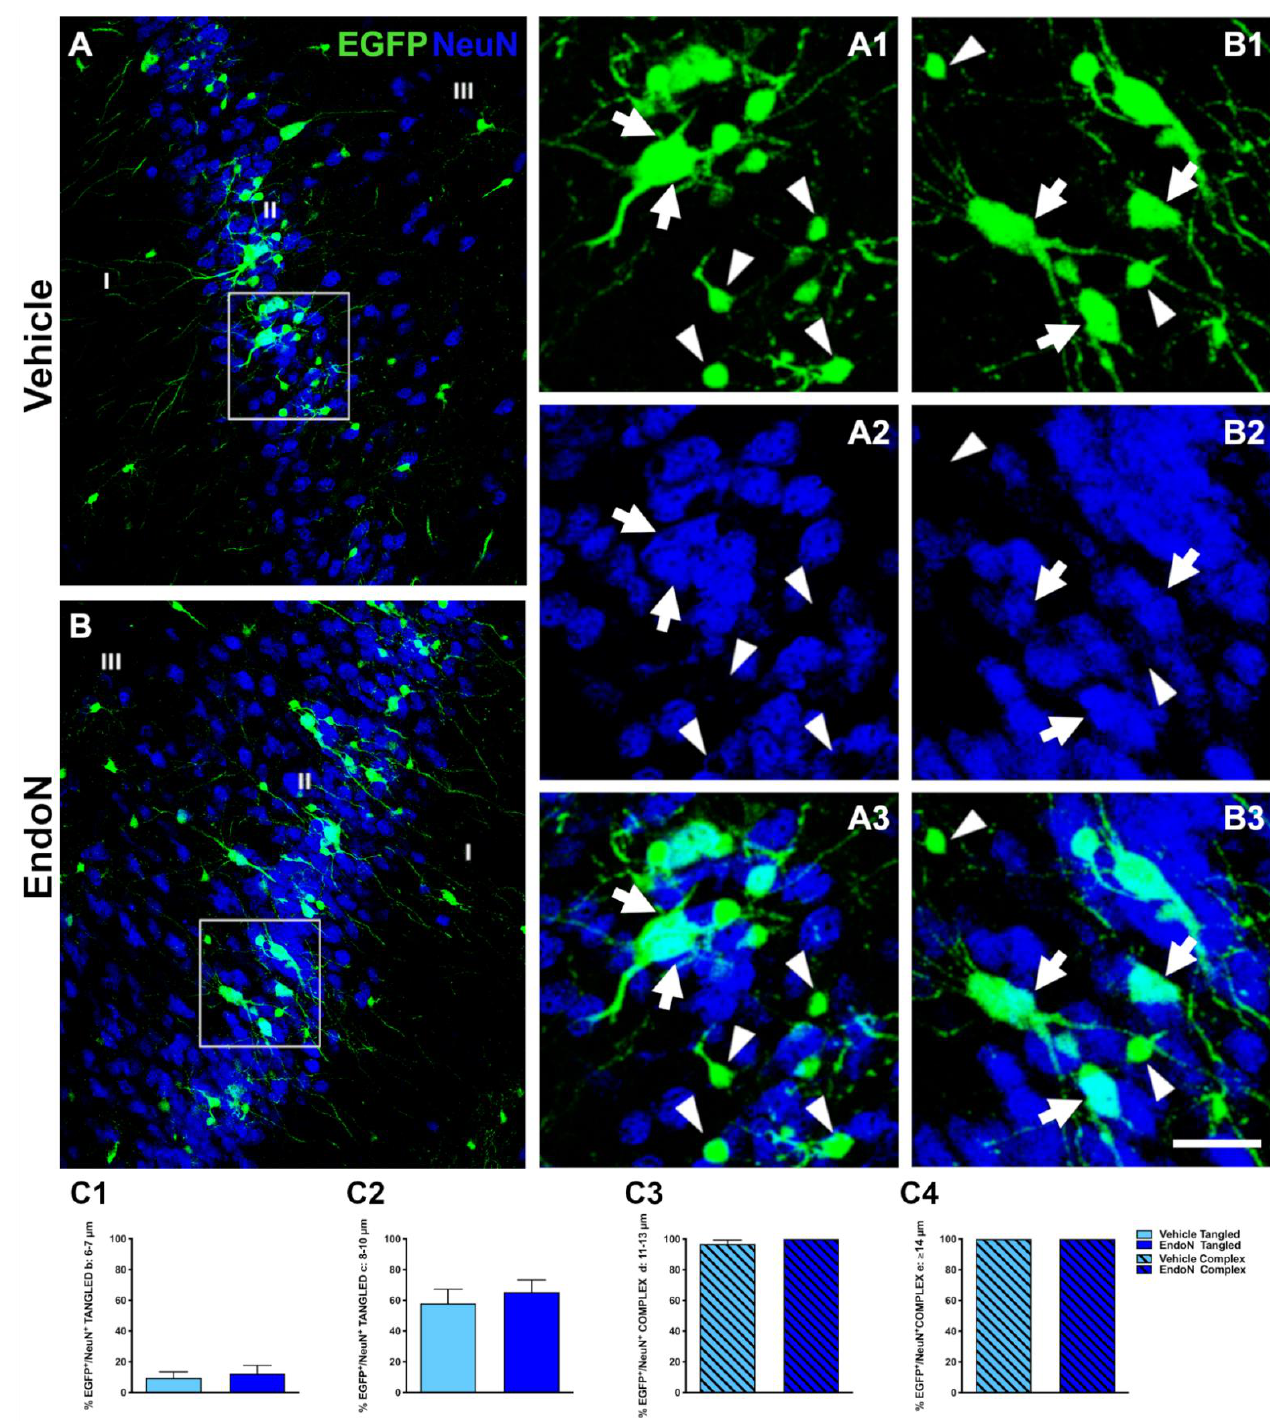
Figure 3. Effects of Endo-N injection on the percentage of EGFP + cells displaying NeuN + nuclei . ( A , B ) Confocal images showing EGFP + cells (green) and NeuN-expressing cells (blue). ( A1 – 3 , B1 – 3 ) Higher magnifications of the squared areas in A and B. In these insets, tangled and complex EGFP + cells are indicated by arrowheads and arrows, respectively. Note the presence of a larger number of EGFP + complex cells labeled with NeuN in the Endo-N hemisphere. ( C1 – 4 ) Graphs representing the percentage of EGFP + /NeuN + neurons classified as tangled or complex cells according to their diameter. Scale bar: 70 µm.